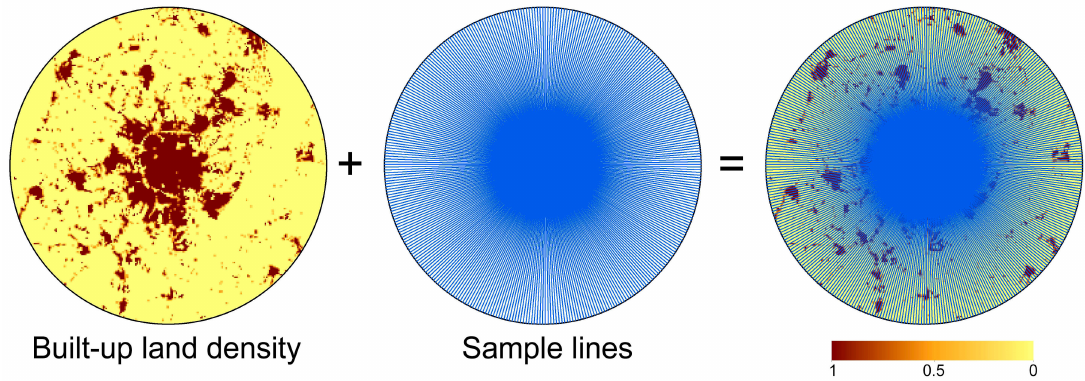
Figure 5. Extraction process of built-up land